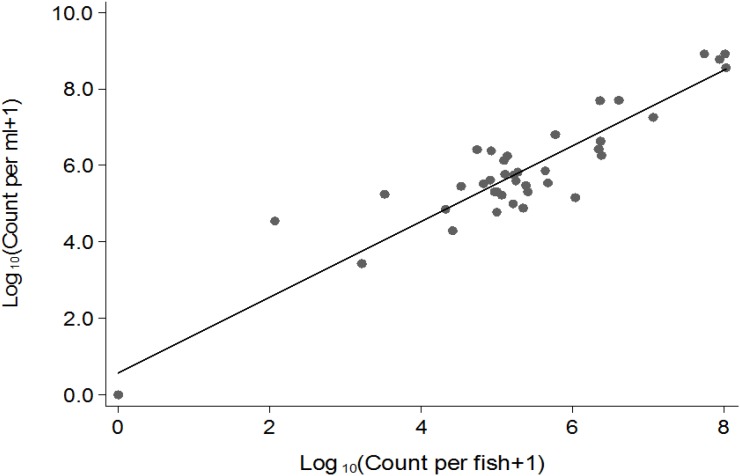
Correlation between Log10 (cfu) in fish (x) and in water (y).